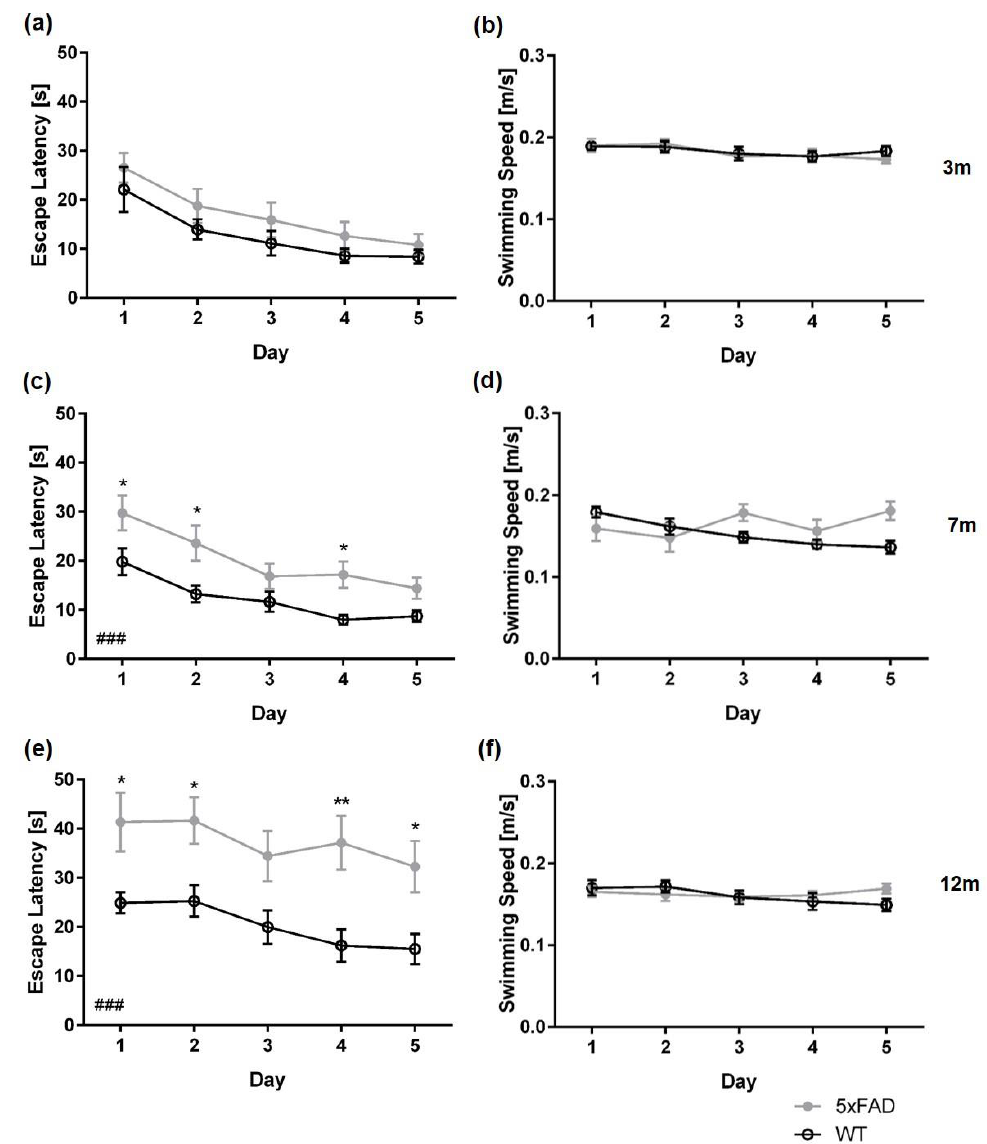
Figure 2. Female 5xFAD mice display age-dependent spatial learning deficits in the acquisition training. Escape latencies of 3- ( a ), 7- ( c ), and 12-month-old mice ( e ). Swimming speed did not differ between 5xFAD and WT mice at any age tested ( b , d , f ). Data presented as mean ± S.E.M., n = 10–13. Two-way repeated measures ANOVA: ### p < 0.001; Bonferroni: * p < 0.05, ** p < 0.01. Female seven-month-old WT mice performed better than 5xFAD animals on days one, two, and four of the acquisition training (Figure 2c: day 1 , day 2 , day 4 : p < 0.05). In contrast, seven-month-old male WT mice performed significantly better than 5xFAD animals only on the first day of acquisition training. (Figure 3c: day 1 : p < 0.001). Furthermore, 12-month-old female 5xFAD mice required significantly more time to find the hidden platform on days 1, 2, 4, and 5 of the acquisition training than WT animals (Figure 2e: all p < 0.01). In addition, 12-month-old male WT mice performed significantly better than 5xFAD mice on days 4 and 5 of the acquisition training (Figure 3e: day 4 p < 0.05; day 5 p <